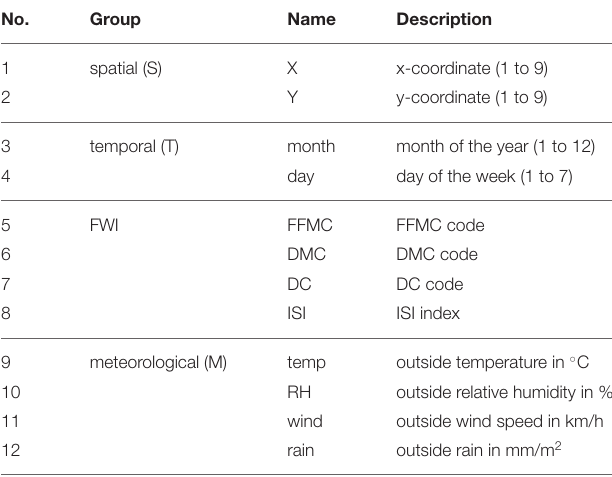
TABLE 1 | Attributes of the forest fires dataset and their corresponding groups.